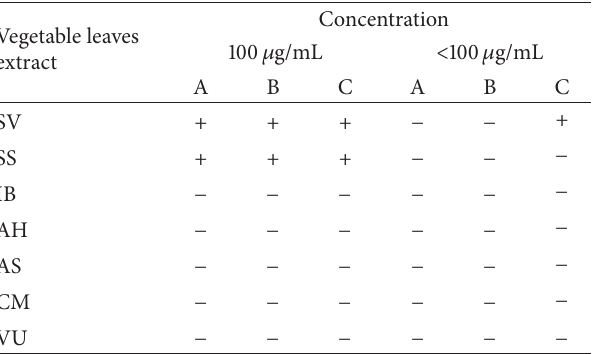
Table 6: Cytotoxicity evaluation of the water extracts against the human MDA-MB-231 cell